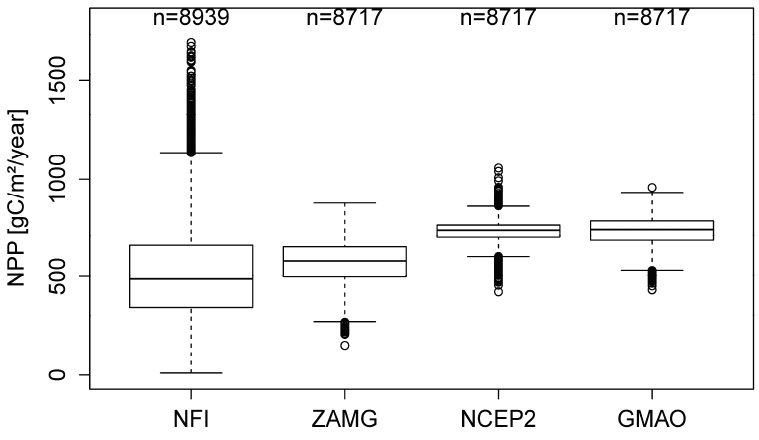
Figure 2. Comparisons of the NPP estimates where (1) NFI —the terrestrial NPP; (2) ZAMG —MODIS NPP estimates using the daily weather data from the Austrian National Weather Centre; (3) NCEP2 —MODIS NPP estimates using the daily weather data of the so called NCEP_DOE_II [42], and (4) GMAO —MODIS NPP using the daily climate data from NASA Global Modeling and Assimilation Office [41]. The box represents the Median and the 25th and 75th quartile, the whiskers extend to 1.5 of the interquartile range, values outside this range are indicated by circles, and on the top the number of values represented by the boxplots is